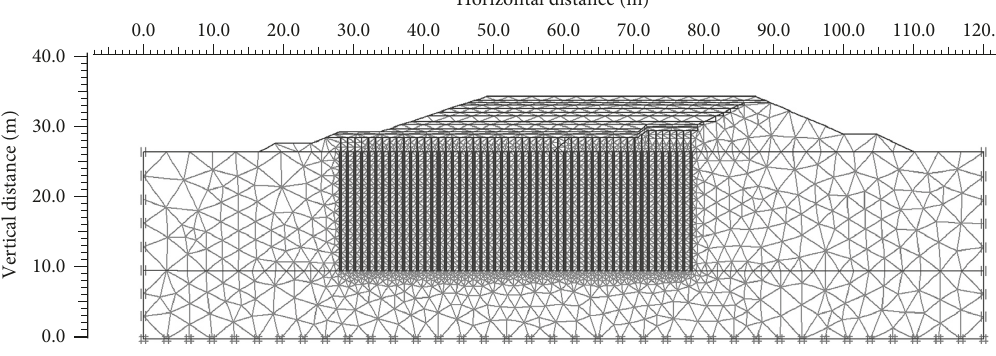
Figure 3: Finite element mesh for plane strain